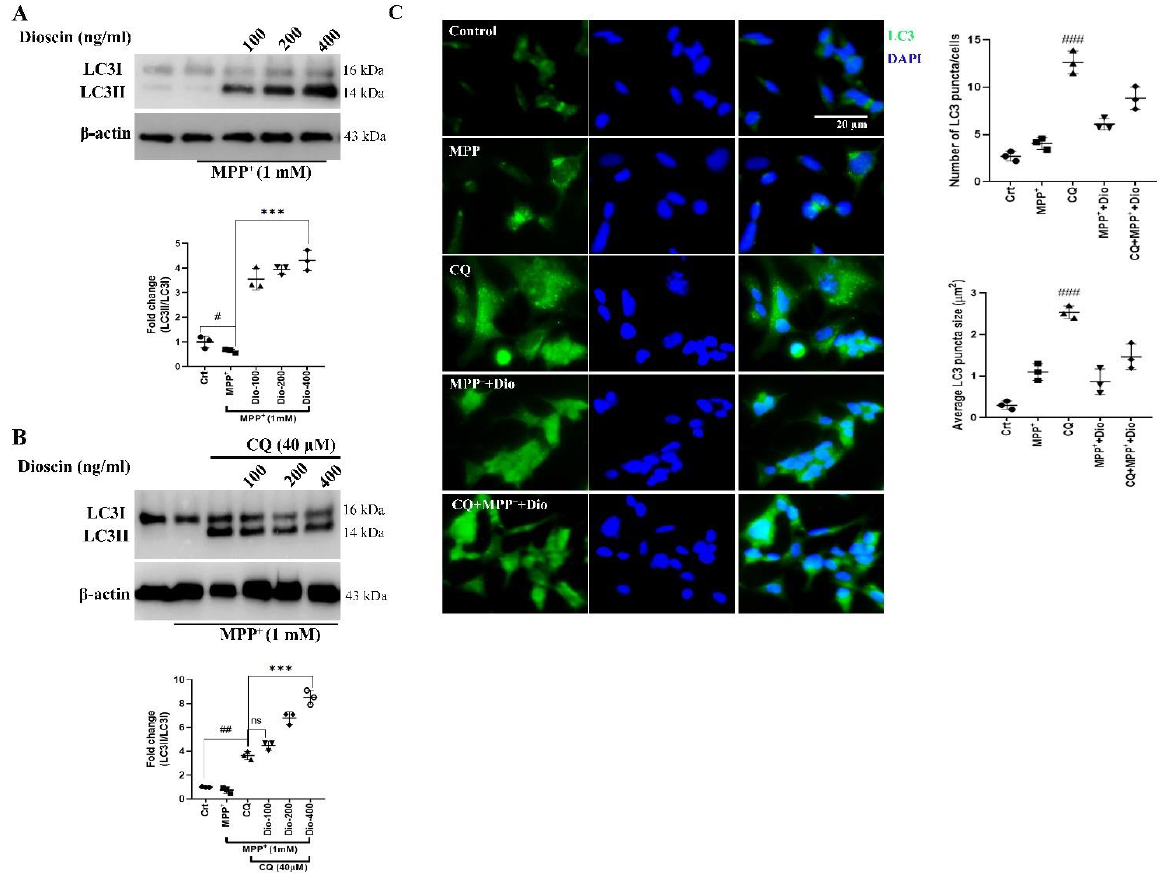
Figure 6. Dioscin dose-dependently activates autophagosome. Representative data of LC3 im- munoblots of whole-cell (SH-SY5Y) lysates. Cells were pre-treated with different doses of dioscin ( A ) and autophagy inhibitor CQ (40 µ M) ( B ), followed by induction of MPP + (1 mM) for 24 h. The conversion of LC3I into LC3II is presented as fold changes measured using Image J software. Each WB is representative of 3 independent experiments. Data in bar graphs represent the ratio of re- spective protein/ β -actin or LC3I normalised against control (non-treated) samples or MPP + or MPP + + CQ-treated cells and are mean ± SEM of 3 independent experiments ( C ) Immunocytochem- istry of autophagic marker LC3 in presence or absence of inhibitor CQ (40 µ M) on MPP + -treated or untreated SH-SY5Y cells; the images were taken by Nikon microscopy (widefield fluorescent microscope; scale bar 20 µ m), and average size and number of LC3 puncta were done by ImageJ software; quantification performed from ≥ 25 cells. ns = not significant; # p < 0.05, ## p < 0.01 and ### p < 0.001, in comparison to non-treated group; * p < 0.05, ** p < 0.01 and *** p < 0.001, compared to toxin and treatment